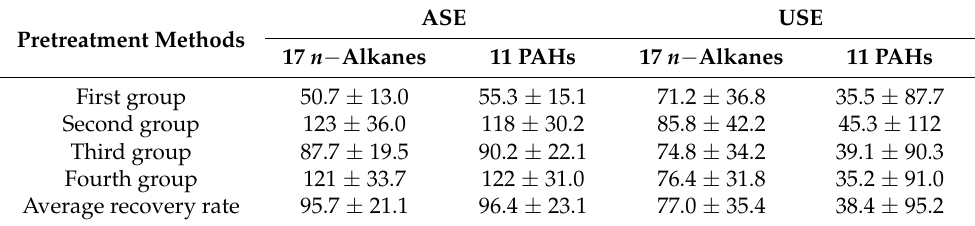
Table 3. The comparison of recoveries of ASE and USE method